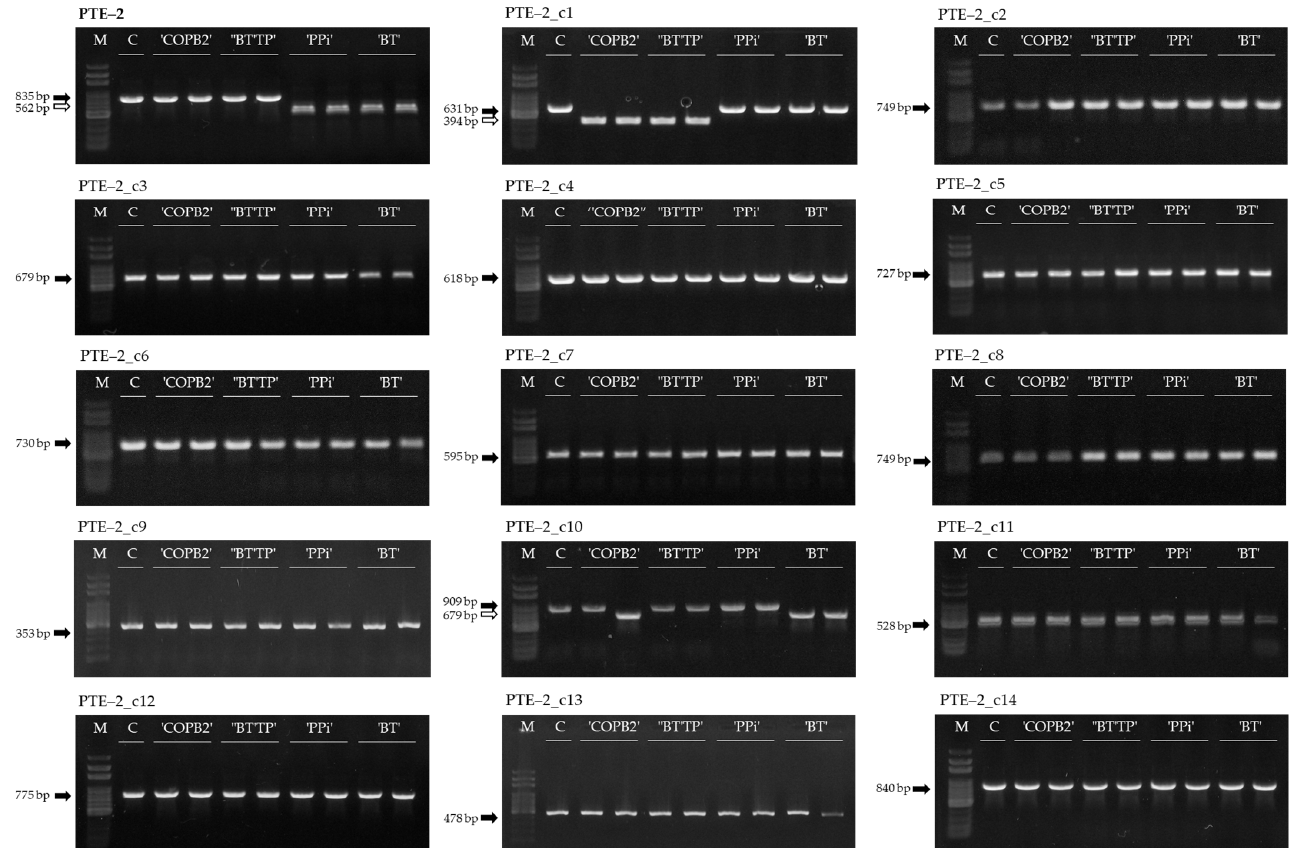
Table 3. The structural characteristics of PTE-2 Figure 5. The activation analysis of PTE-2 and copy elements at different loci by MIP PCR analysis. M, 100 bp DNA ladder; C, ‘CT001’; ‘COPB2’, ‘COPB2’ transgenic lines; ‘BTTP’, ‘BTTP’ transgenic lines; ‘BT’, ‘BT’ transgenic lines; ‘PPi’, ‘PPi’ transgenic lines. Black arrow, MITE-inserted amplicon; White arrow, MITE-excised amplicon.